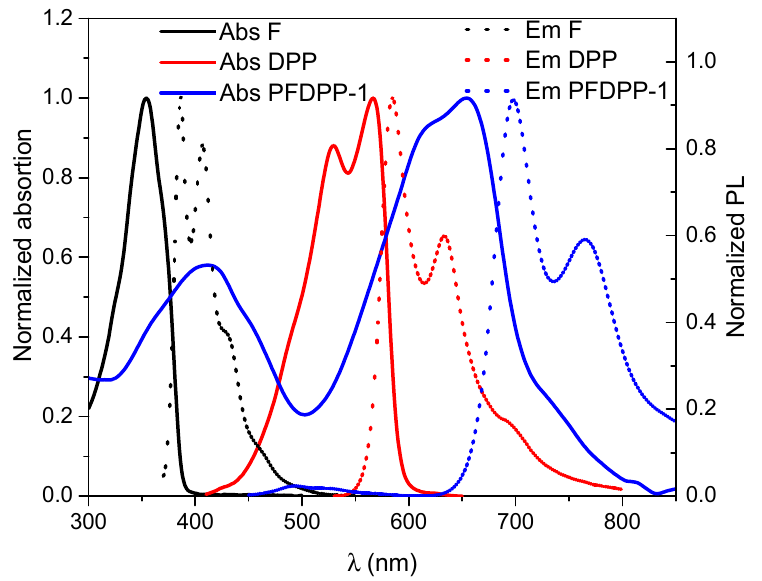
Figure 7. Normalized absorption and emission of the fluorene monomer (F), diketopyrrolopyrrole (DPP) monomer, and PFDPP-1 in chloroform. λ ex = 350 nm, λ ex = 530 nm and λ ex = 410 nm.